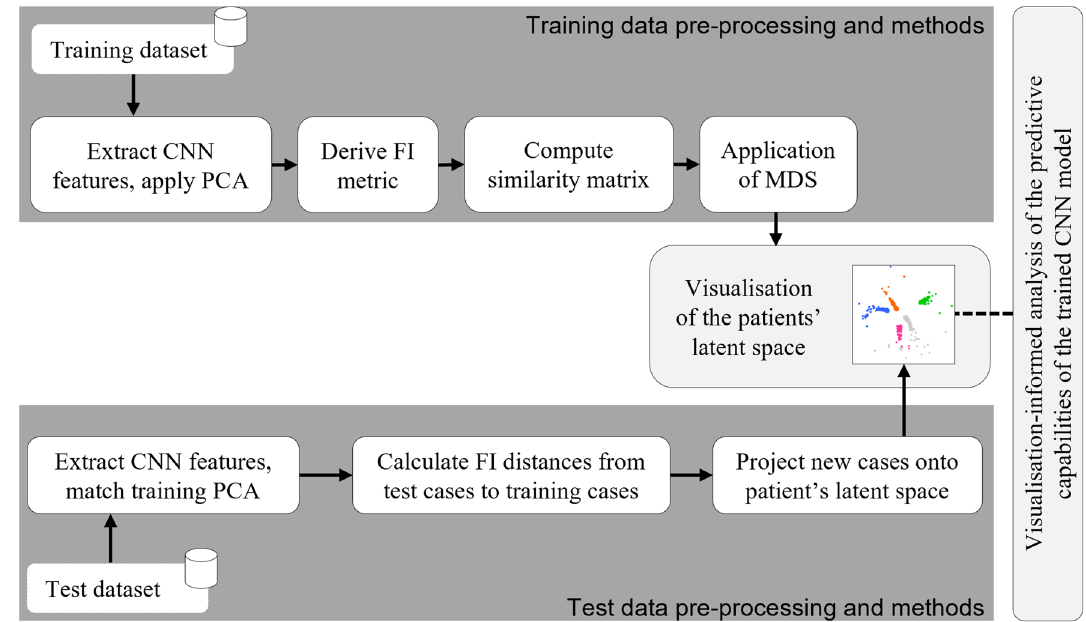
Figure 1. Proposed methodology. Utilising the FIN to create a visualisation of the latent space of cancer patients, exploiting the predictive capabilities of a deep learning